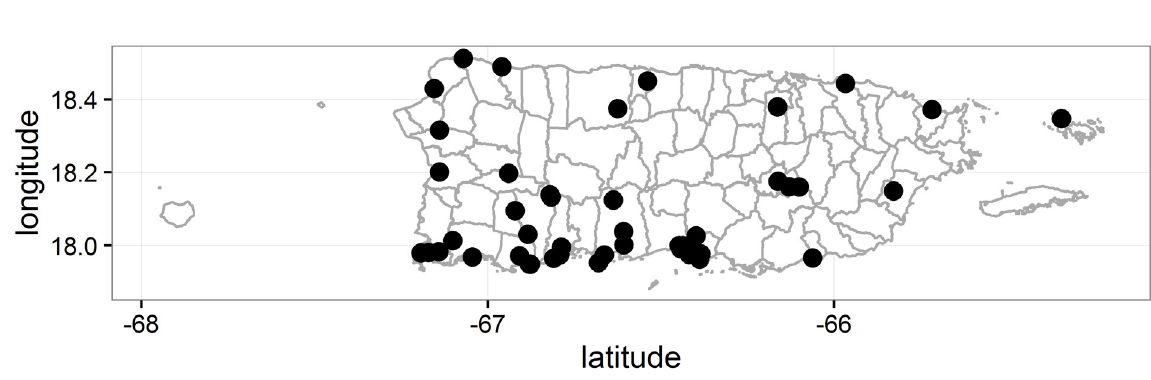
Fig. 11. Distribution map for Lasioglossum enatum sp. nov. in Puerto